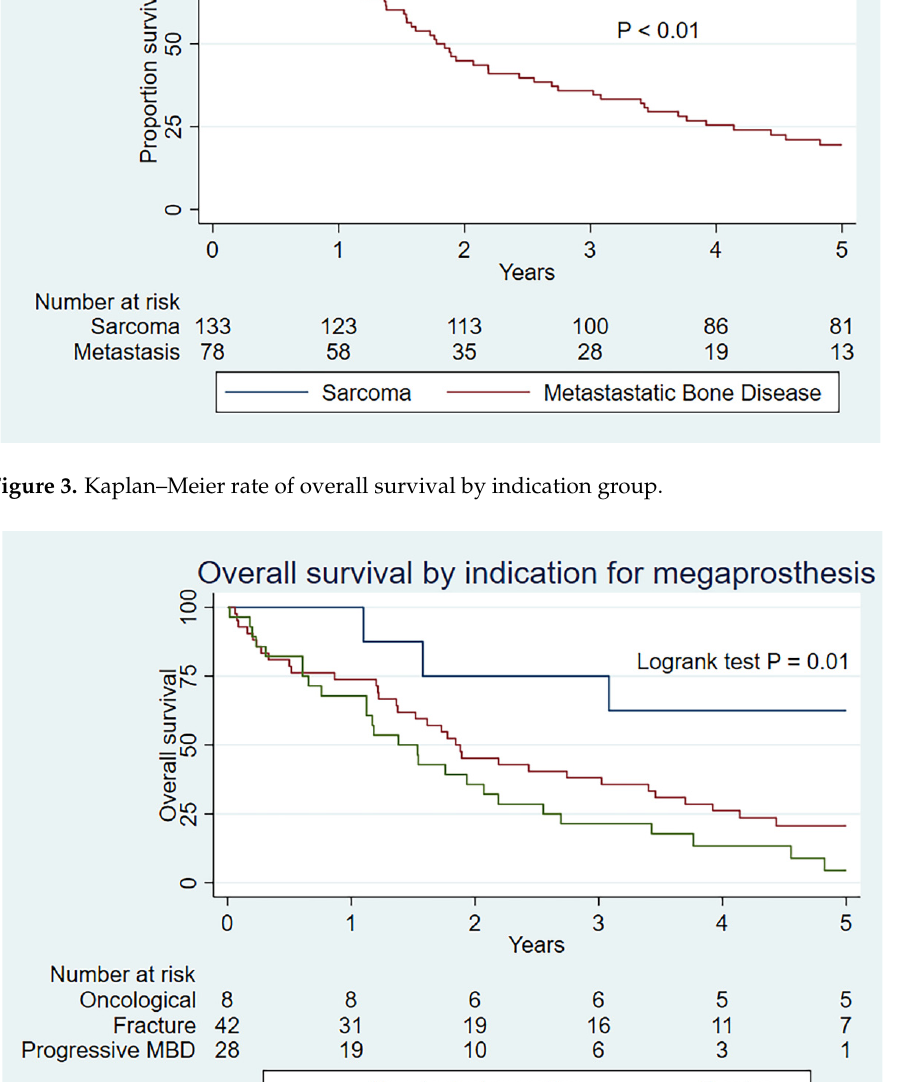
Figure 4. Kaplan–Meier rate of overall survival by indication group for metastatic